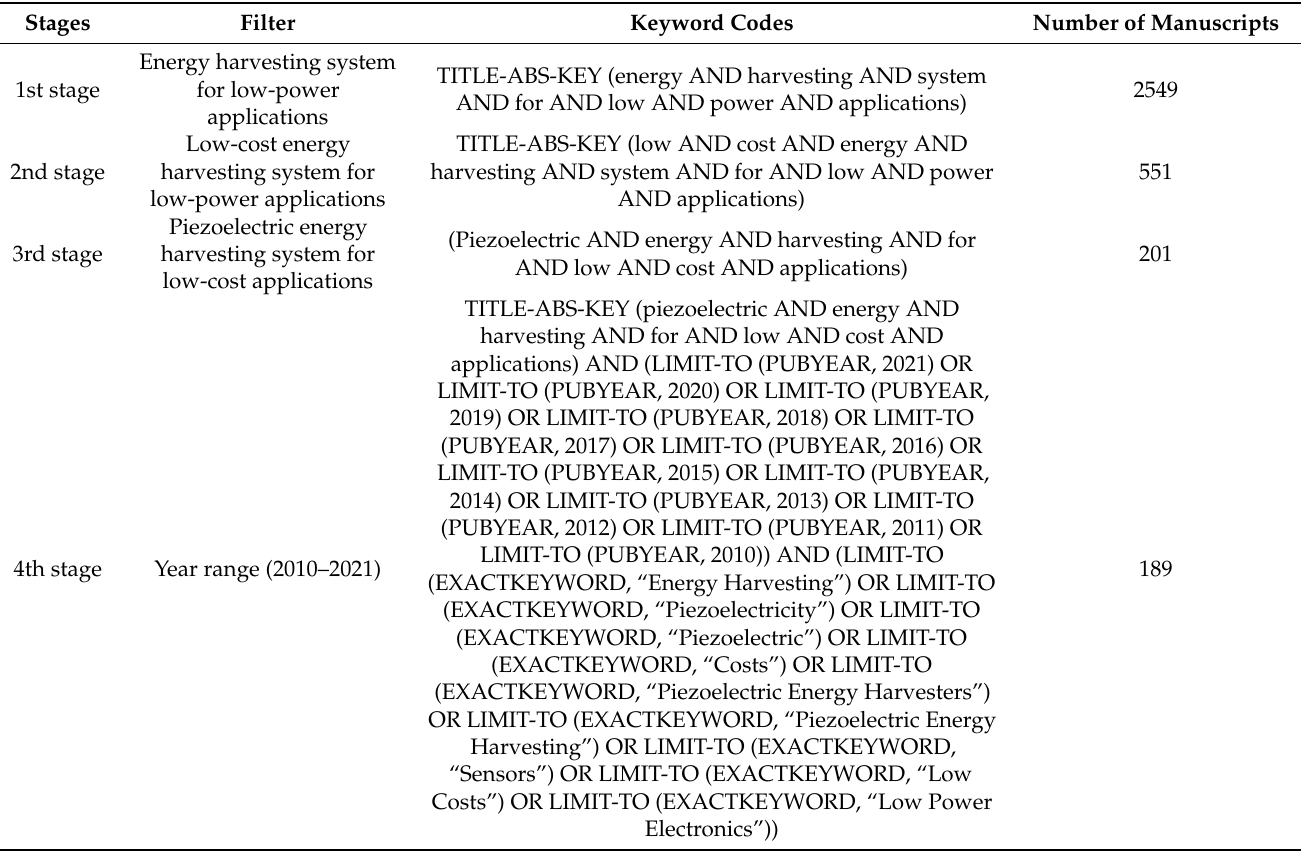
Table 2. Potential of articles in the Scopus